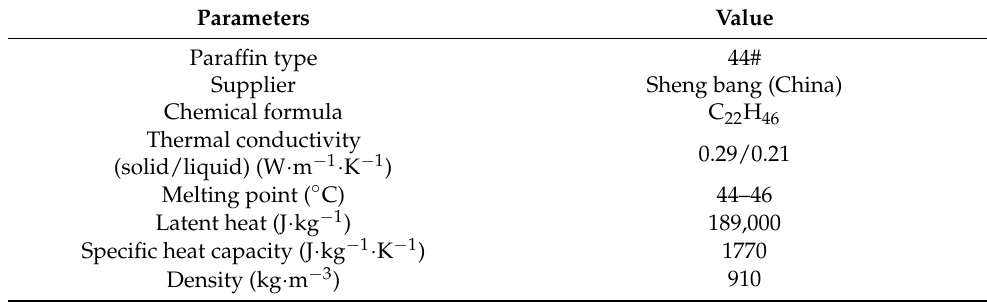
Table 2. Physical properties of paraffin.